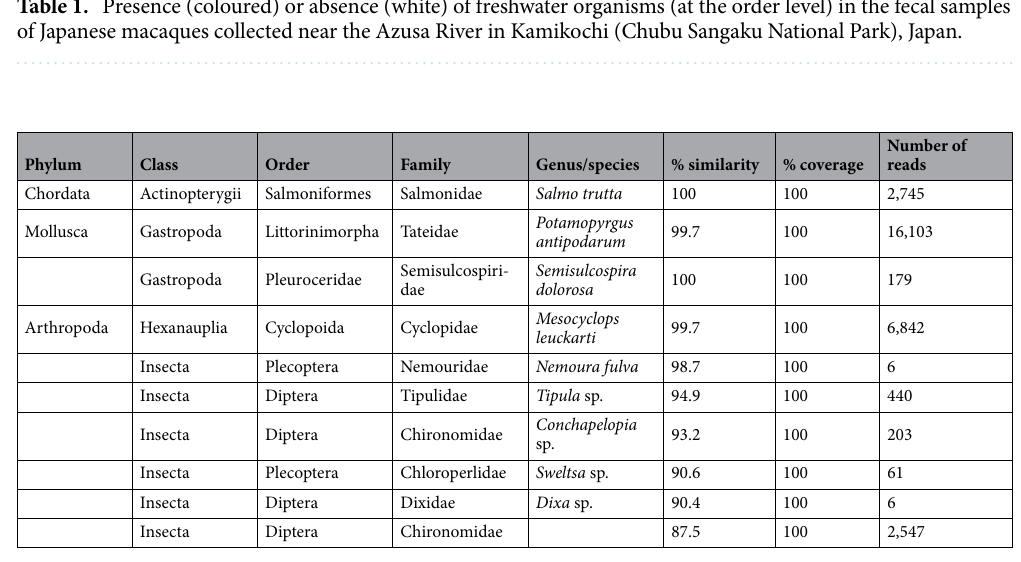
Table 2. BLAST results from freshwater chordates, molluscs and aquatic arthropods (or arthropods having aquatic life stages) sequences identified in the fecal samples of Japanese macaques. % similarity = percentage of similarity between the sequences found in the fecal samples and the sequences in the GenBank database; % coverage = percentage of the sequence found in our sample aligned to a sequence in GenBank; number of reads = number of times that same sequence occurred in the